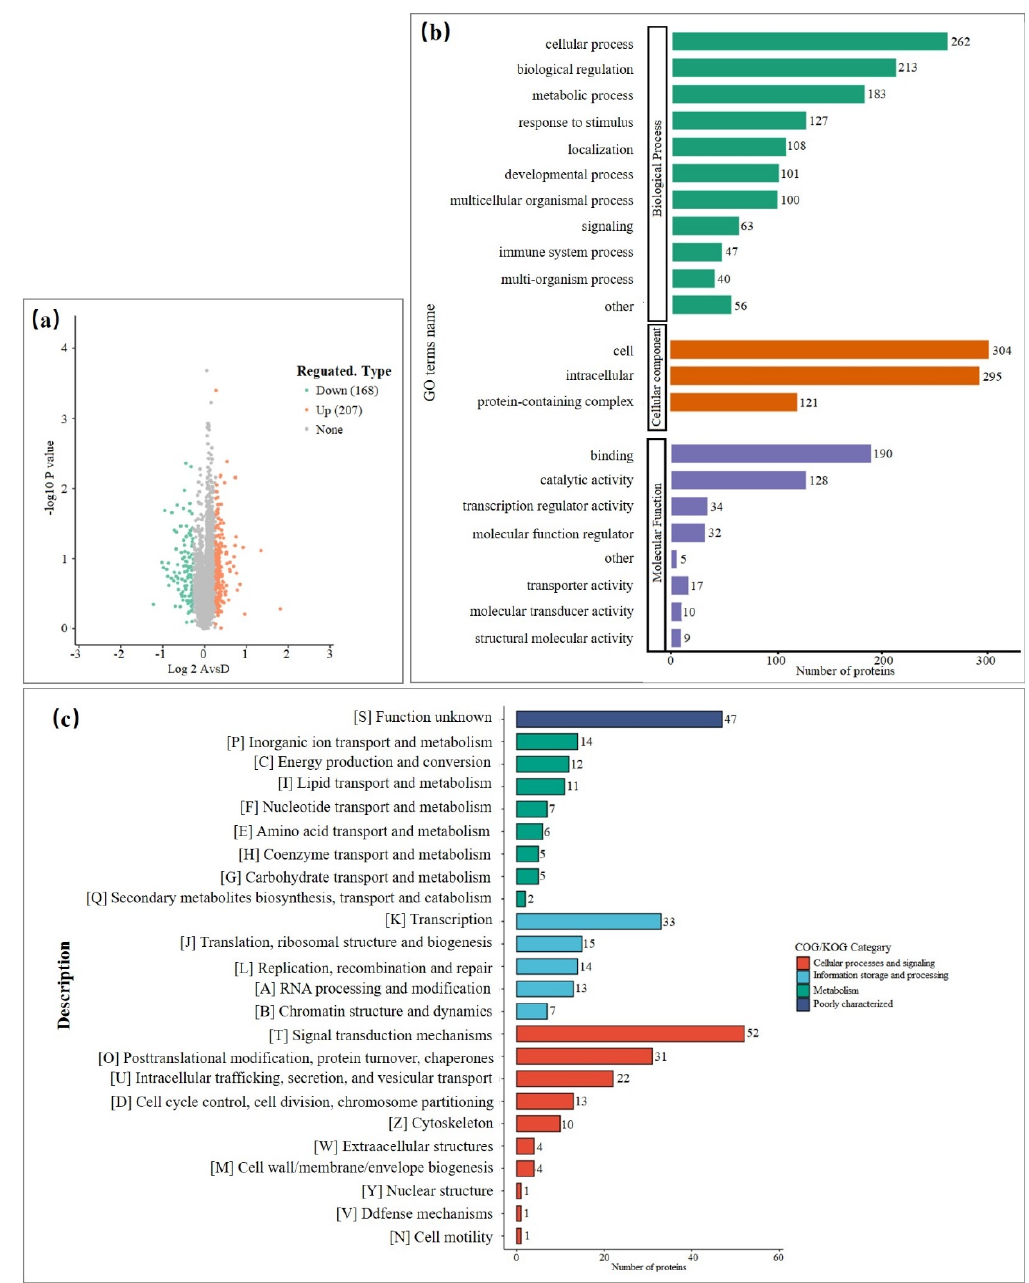
Figure 3. Proteomic analysis of PK15 cells following PAstV/SH/2022/CM1 infection. ( a ) Volcano plots show the regulated proteins of cells following PAstV infection. Proteins differentially expressed (DEPs) with fold change over 1.2 and p < 0.05 are marked in color. p -values were calculated using a two-sided, unpaired Student’s t test with equal variance assumed ( n = 3 independent biological samples). ( b ) Gene Ontology (GO) enrichment analysis of DEPs based on biological process. ( c ) Clusters of Orthologous Groups of proteins (COG/KOG) category of DEPs including cellular processes and signaling, information storage and processing, metabolism, and poor